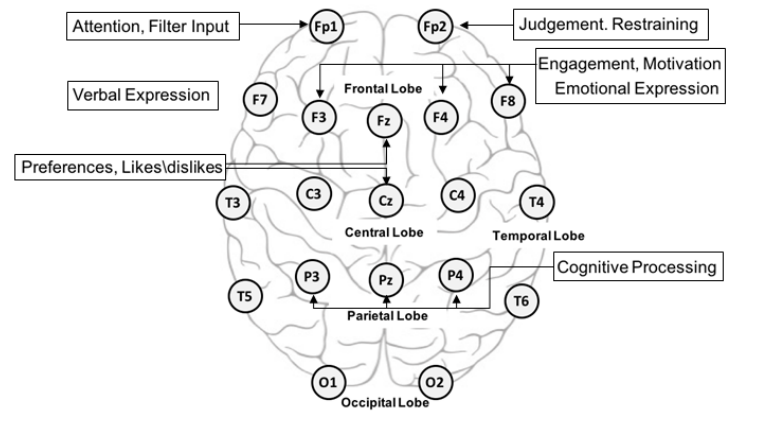
Figure 2. EEG electrodes and related neural